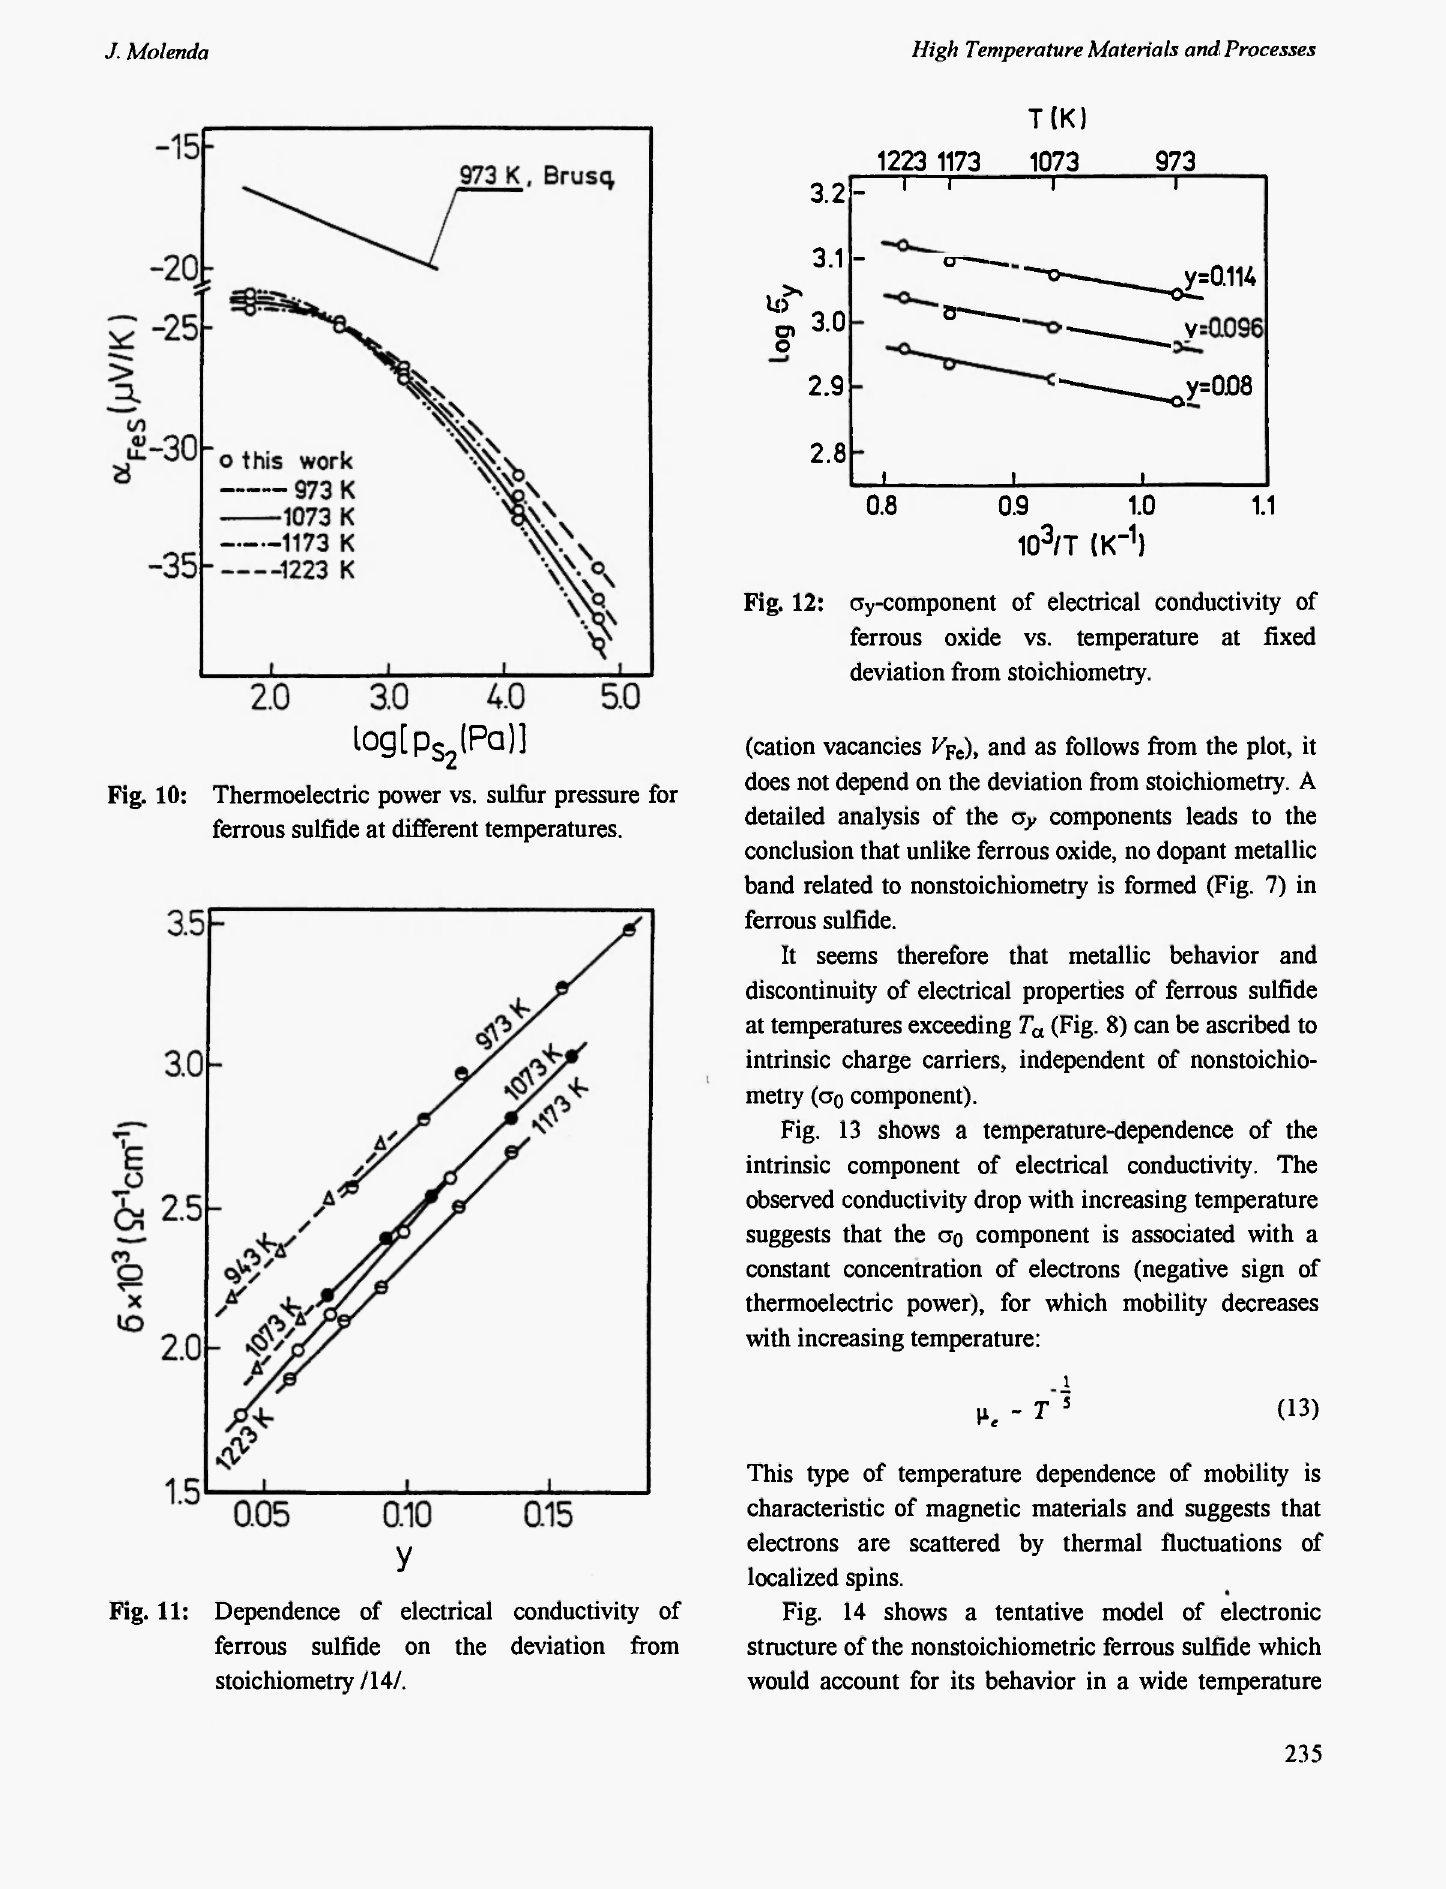
Fig. 11: Dependence of electrical conductivity of ferrous sulfide on the deviation from stoichiometry /14/.